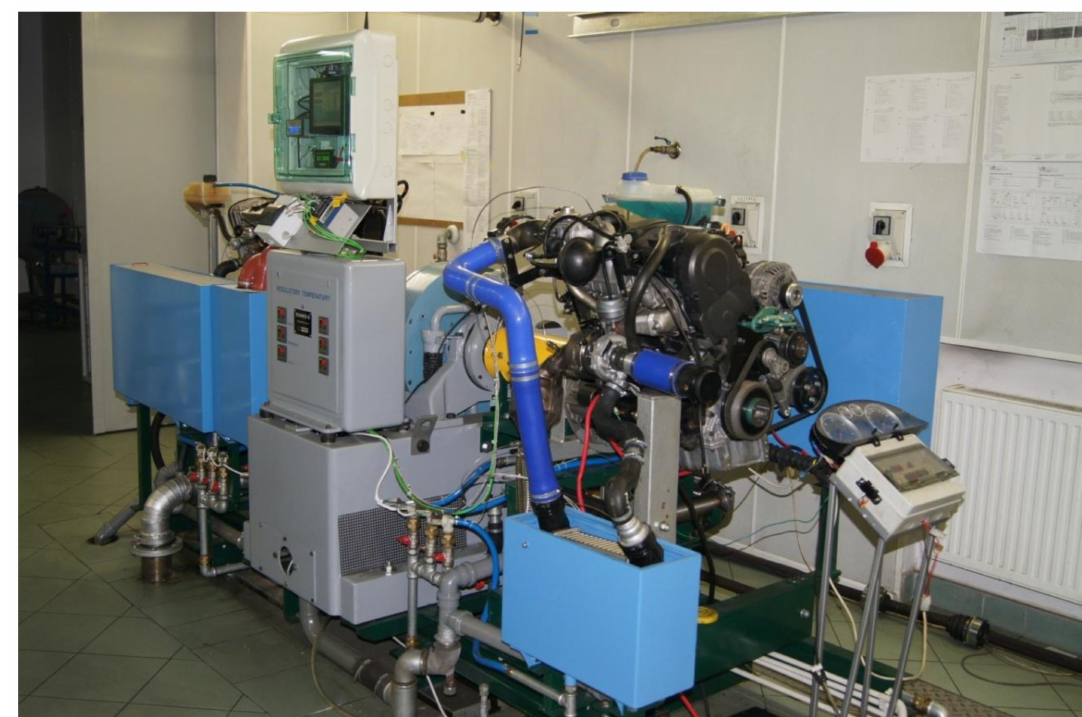
Figure 2. Test bench with the Schenck eddy current brake and VW 1.9 TDI engine.